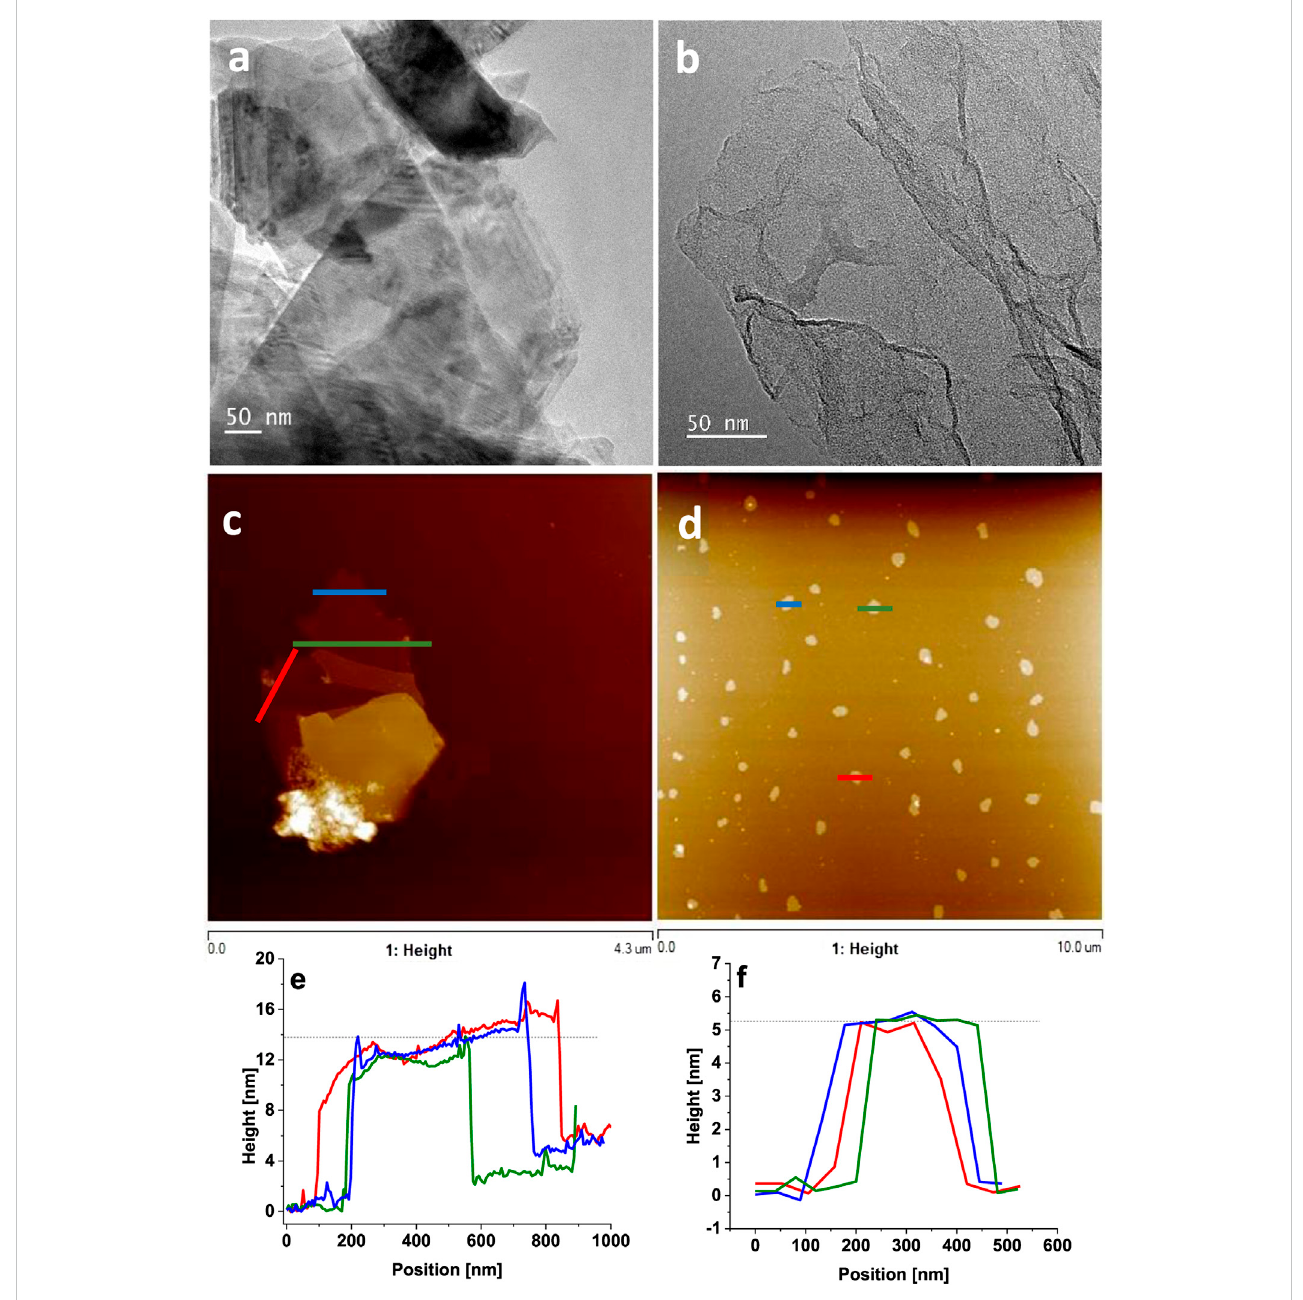
FIGURE 1 TEM and AFM images of (A) WS 2 , (B) GO, (C) WS 2 , and (D) GO and height pro fi les of (E) WS 2 and (F)